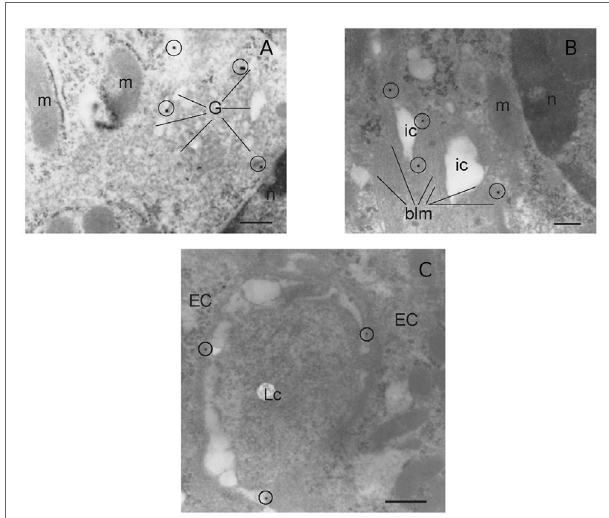
FigUre 2 | Morphological analysis of IL-12R β 2 on IECs. Transmission electron micrograph analysis (immunogold staining) of mouse small intestine showed that IL-12R β 2 in IECs was found in the Golgi (a) as well as the basolateral membrane (B) and at the interface between IECs and lymphoid cells (c) . G, Golgi; EC, epithelial cell; LC, lymphoid cell; m, mitochondria; n, nucleus; ic, intracellular space; blm, basolateral membrane; IECs, intestinal epithelial